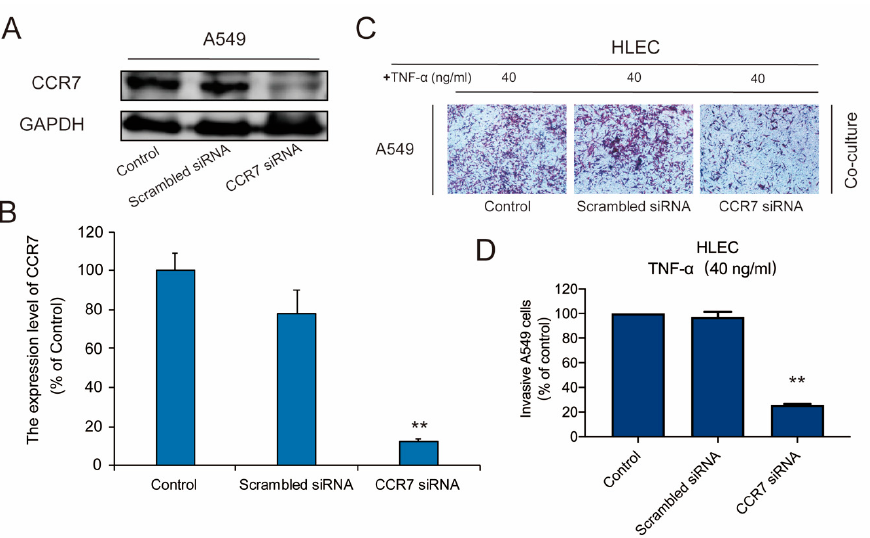
Figure 6. HLEC co-culture-induced metastasis and invasion of A549 cells is CCR7 dependent. A549 cells were transfected with Scrambled siRNA and CCR7 siRNA, and then co-cultured with HLEC